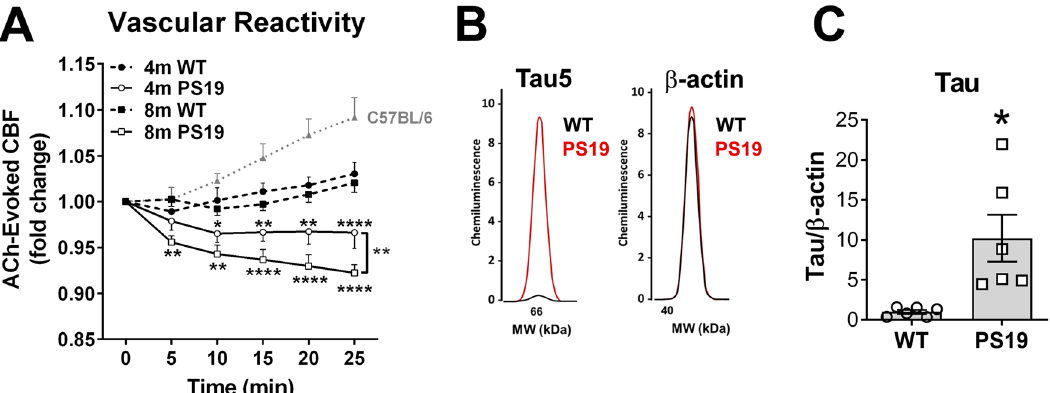
Fig. 4 | Soluble tau aggregate accumulation in brain microvasculature of P301S(PS19) mice is associated with profound de fi cits in endothelium- dependent vasodilation.A Impaired endothelium-dependent cerebralblood fl ow (CBF) responses in male and female P301S(PS19) mice in response to topical acetylcholine (ACh) stimulation as compared to WT animals worsen with age (F(3,125)=53.04, ANOVA, p <0.0001. * indicates Tukey ’ s q(126)=3.80, ** indicates Tukey ’ s q(126)=4.66, p <0.007; **** indicates Tukey ’ s q(126)=6.16, p <0.0001). Thebrackethighlightssigni fi cantworseningofendothelialdysfunctionwithagein P301S(PS19) mice, ** Tukey ’ s q(126)=4.61, WT 4 months, n =6; PS19 4 months, n =6;WT8months, n =7;PS198months, n =6mice.Four-month-oldanimalswere